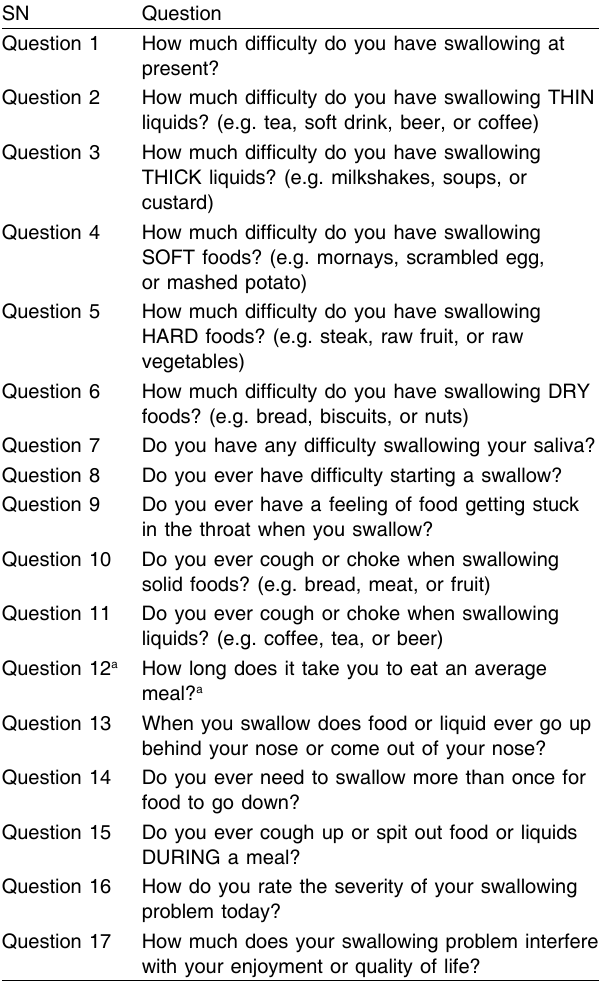
Table A1 Layout of the component questions of the Sydney Swallow Questionnaire